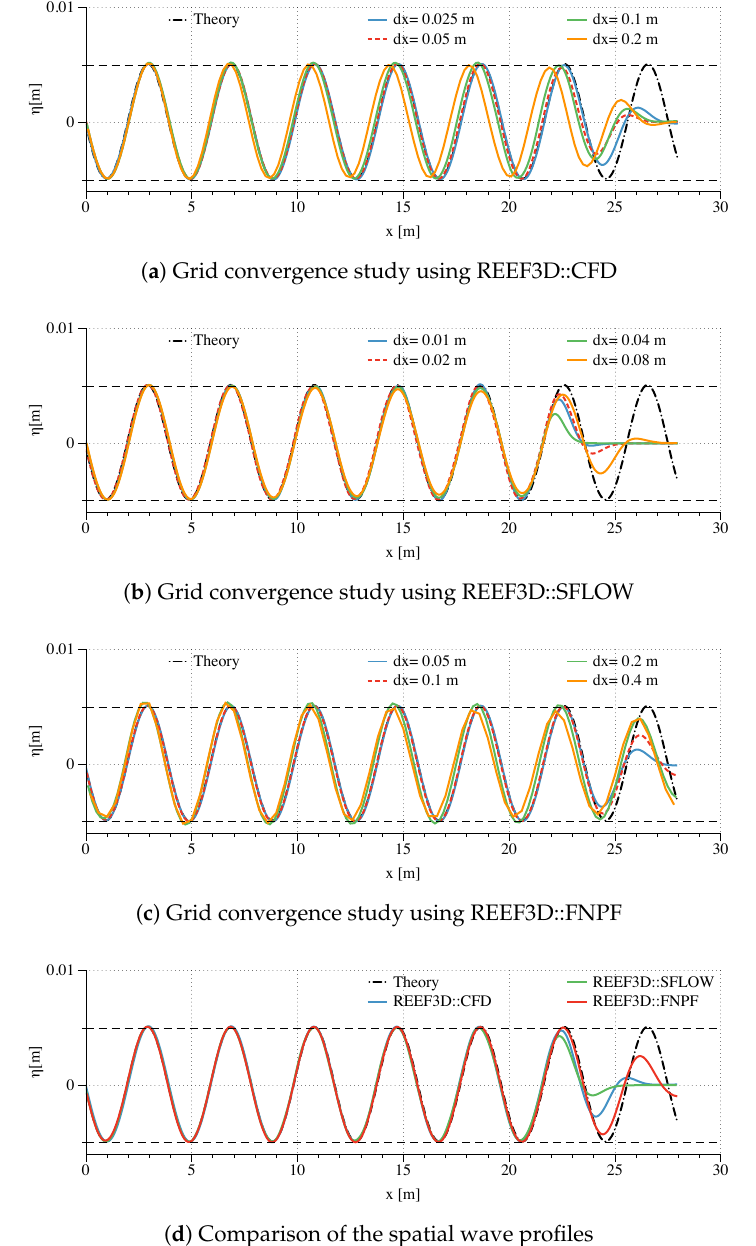
Figure 1. Convergence study on cell sizes for the 2D regular linear wave simulation and the comparison of free surface elevation among the three modules. ( a – c ) grid convergence study, ( d ) comparison of the spatial wave profiles using the finest cell sizes.